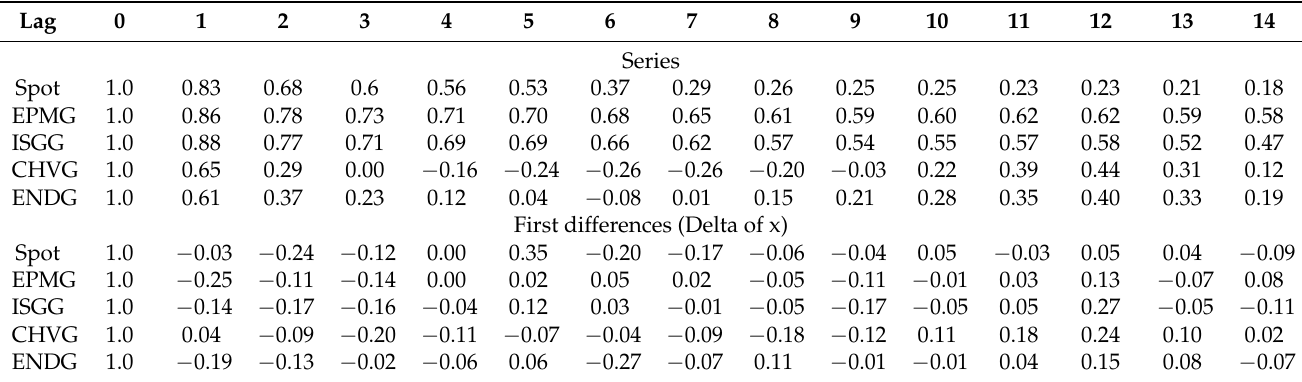
Table 2. Autocorrelation of the